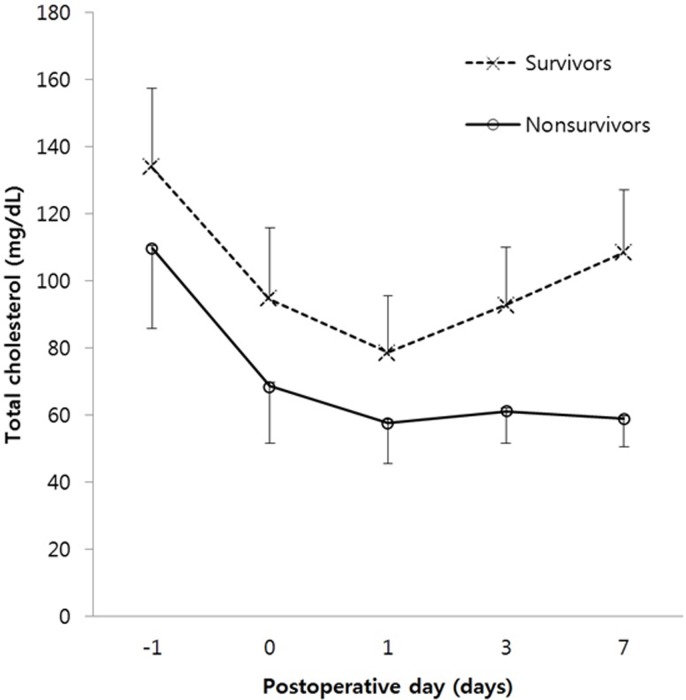
Comparison of the changes in total cholesterol levels between survivors and nonsurvivors.The time variations in total cholesterol levels were significantly different between survivors and nonsurvivors (Greenhouse-Geisser corrected, P < 0.001, using repeated-measures analysis of variance).